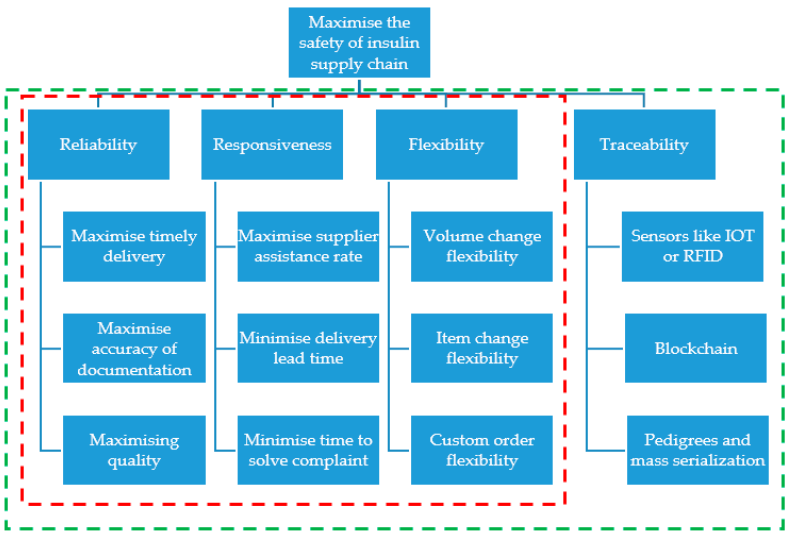
Figure 7. Finalized SCOR metrics for scenarios 1 and 2.